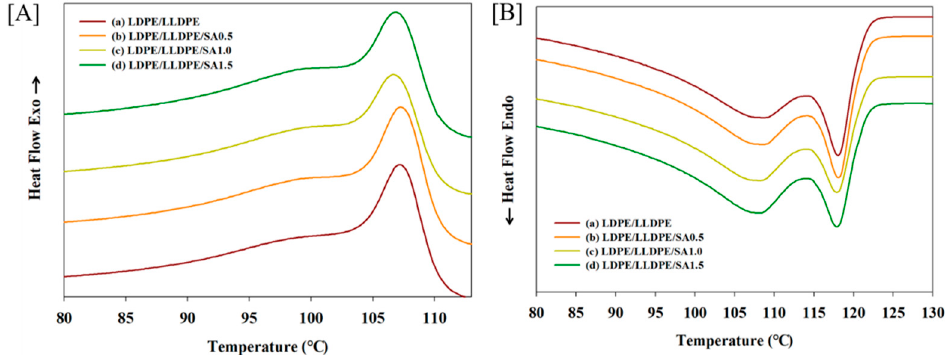
Figure 7. The DSC cooling curves ( A ) and heating curves ( B ) for the LDPE/LLDPE blend film with various SA contents: (a) 0 wt.% (b) 0.5 wt.%, (c) 1 wt.%, and (d) 1.5 wt.%.